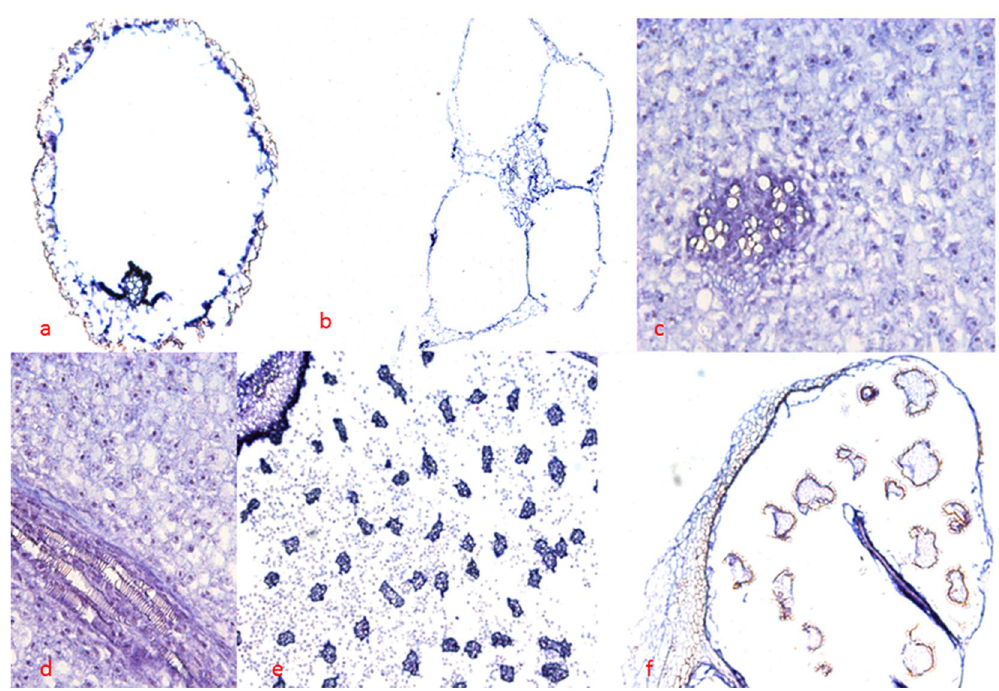
Figure 5. In situ hybridization of IsLFY1 expressions. ( a ) Transverse section of roots. ( b ) Transverse section of leaves. ( c ) Transverse section of corms. ( d ) Longitudinal section of corms. ( e ) Transverse section of microsporangia. ( f ) Transverse section of megasporangia. Scale bars were 300 μ m for megasporangia and microsporangia, 200 μ m for root, leaves, and 100 μ m for